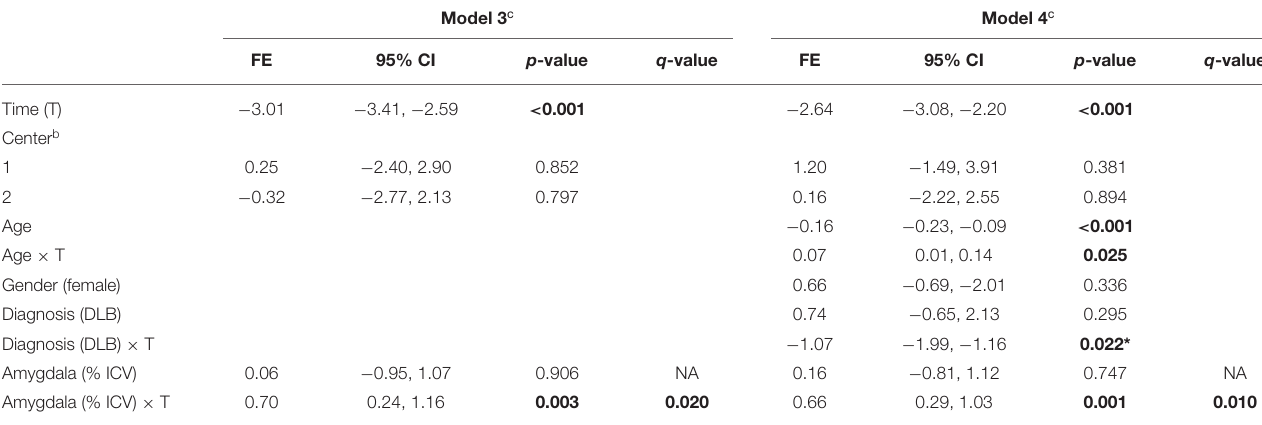
TABLE 2B | Amygdala volume and MMSE over 5